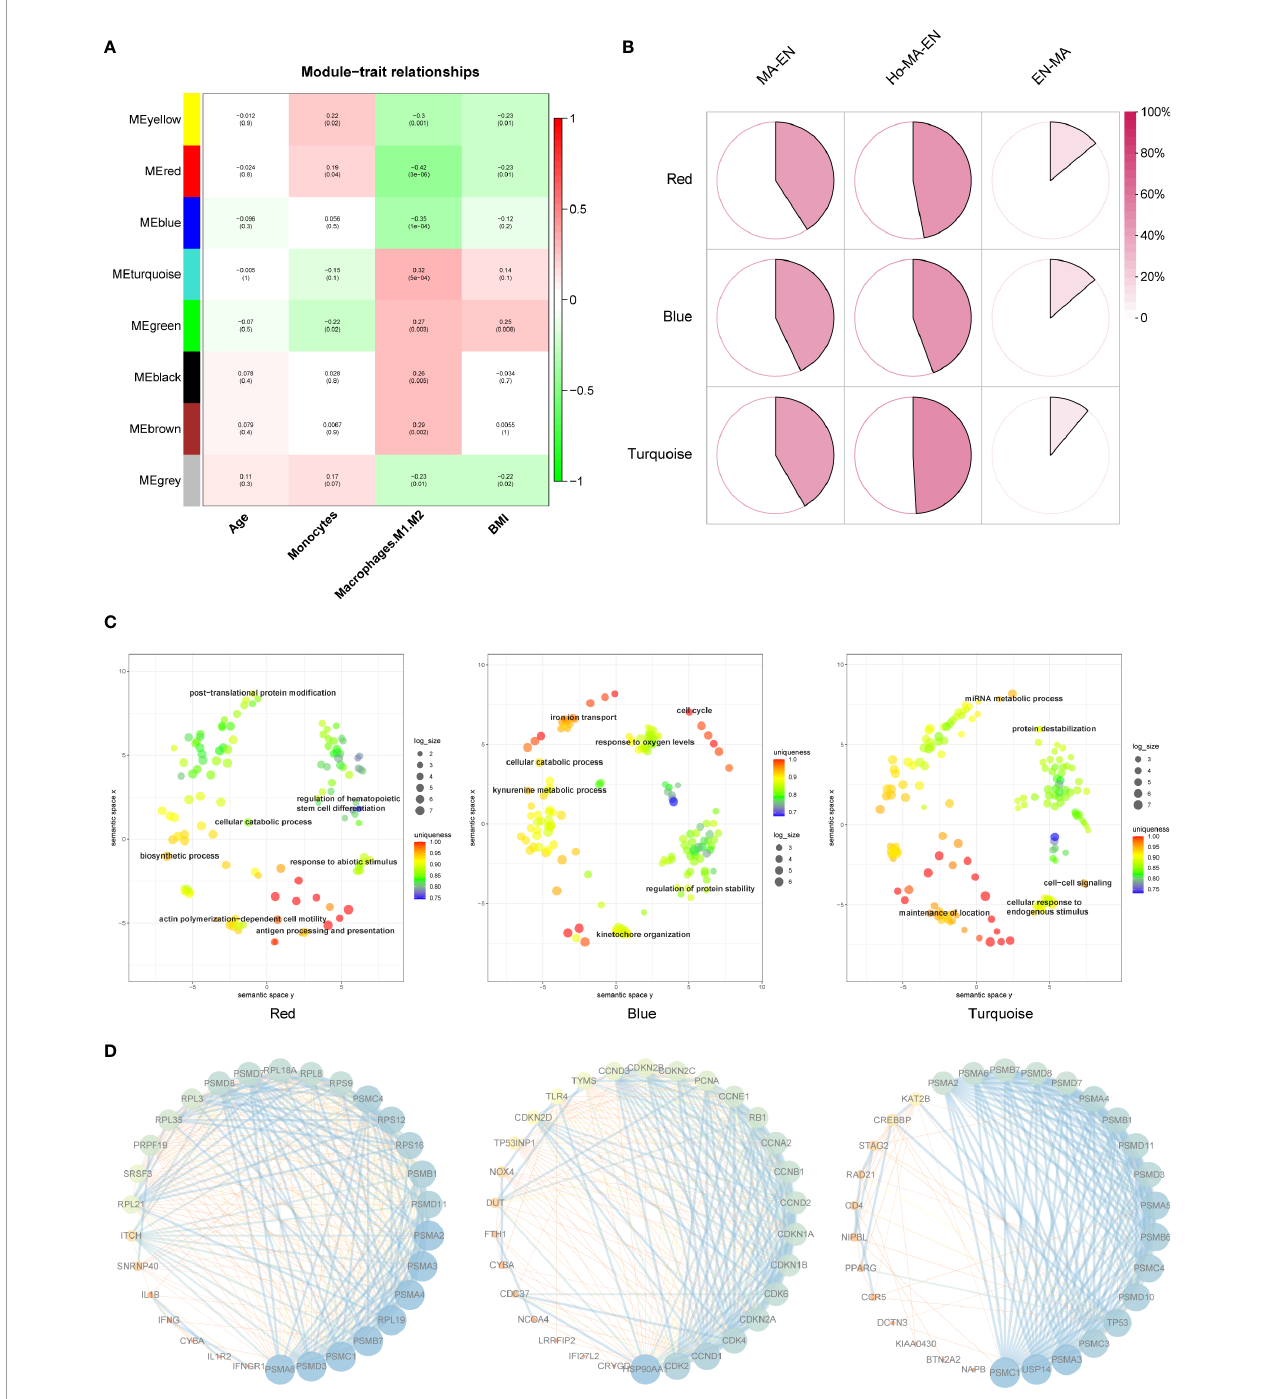
FIGURE 3 | M f 1/M f 2-related WGCNA and module enrichment analyses. (A) Heatmap showing the average genetic signi fi cance of each particular module across clinical traits. (B) Percentage of GSE19834 DEGs within the modules. Percentages within modules are, from left to right, 40.9%, 47.0%, and 14.0% (red), 42.9%, 44.3%, and 13.7% (blue), 41.7%, 49.1%, 11.1% (turquoise), respectively. Ho-Ma-En=Endometrial cells in estradiol progesterone macrophage medium, Ma- En=Endometrial cells in macrophage conditioned medium, En-Ma=Macrophages in endometrial cell medium. (C) REVIGO plot of the red, blue, and turquoise modules (left to right). The scatterplot shows the cluster representatives in a two-dimensional space obtained by applying multidimensional scaling to the semantic similarities matrix of GO terms. (D) Protein-protein interaction (PPI) network of representative genes in each module. Each module has 30 representative genes selected according to their “ degree ”